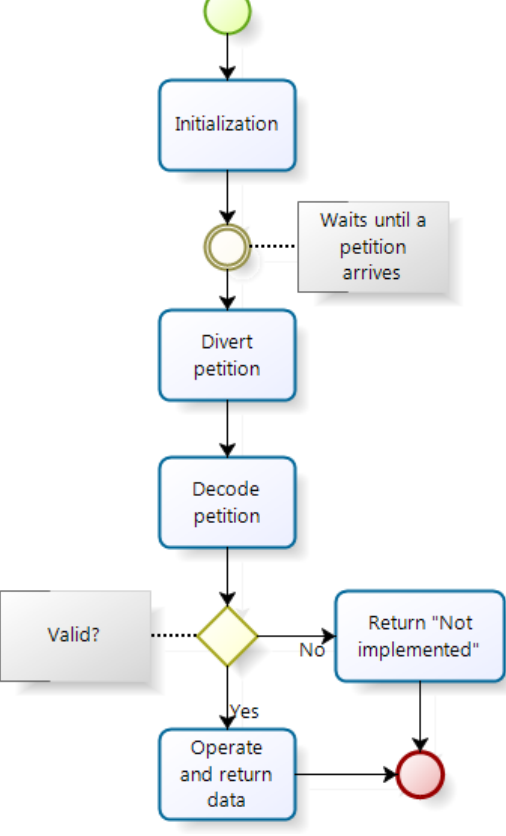
Figure 10. Server threads flow of